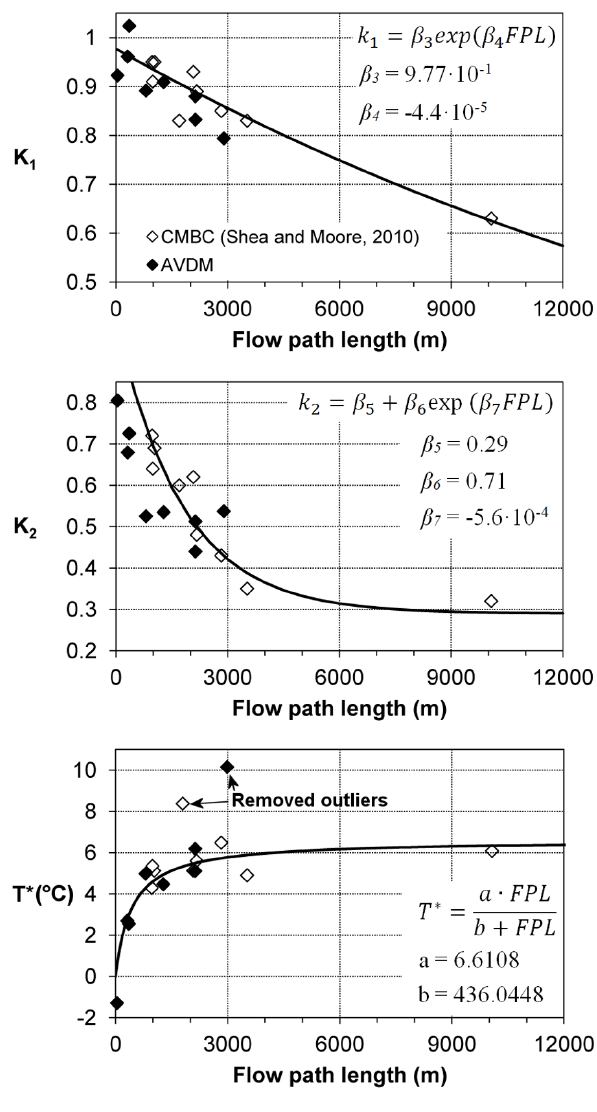
Figure 6. Transfer functions for the coefficients K 1 , K 2 , and T ∗ of the Shea and Moore (2010) method. CMBC is the S&M study area; AVDM is our study area. Outliers due to undersampling at freezing temperatures have been removed (as in the S&M work). β 3 to β 7 are coefficients from S&M (J. M. Shea, personal communication, 2014), while the transfer function and coefficients for T ∗ are new results from the present